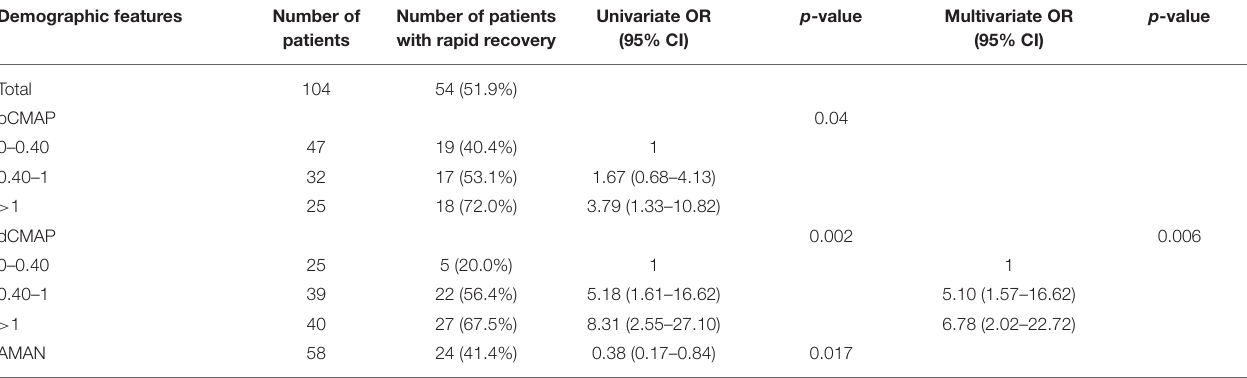
TABLE 4 | Univariate and multivariate regression analyses of factors of rapid recovery in the GBS patients after treatment. Demographic features Number of Number of patients patients with rapid